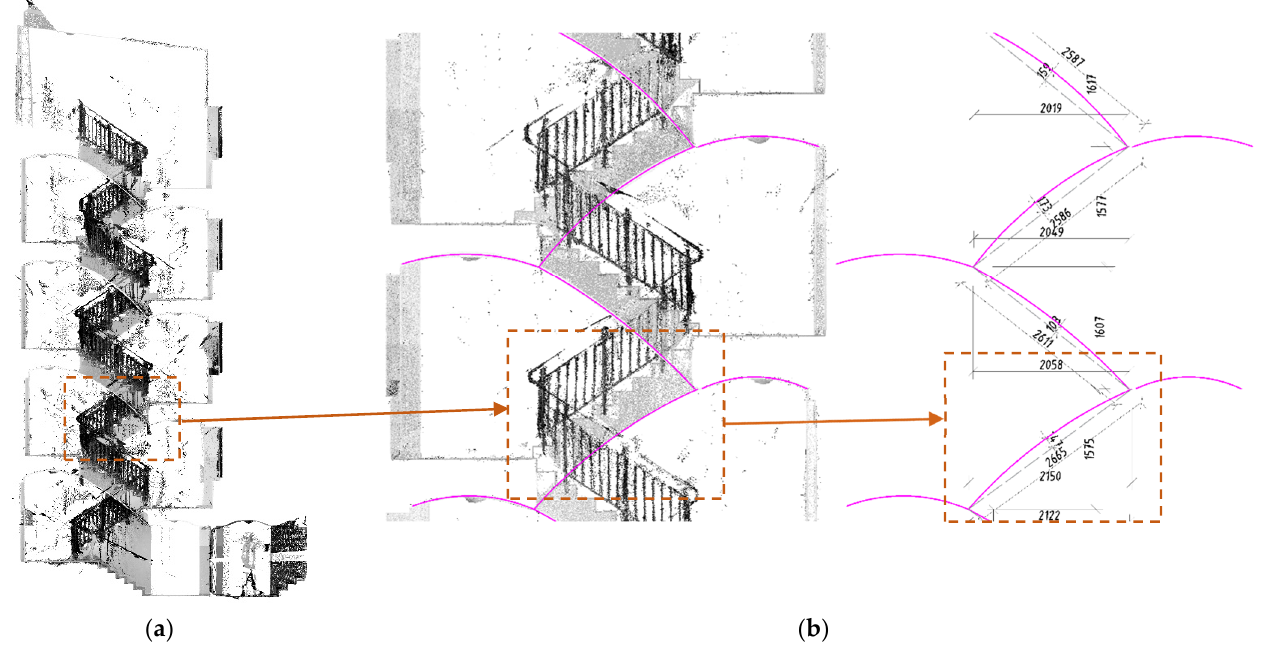
Figure 6. TLS data acquired from existing building: section view of building ( a ) and geometry measurements for analysis ( b ). The dashed line marks the stair flight which was subjected to further laboratory testing.